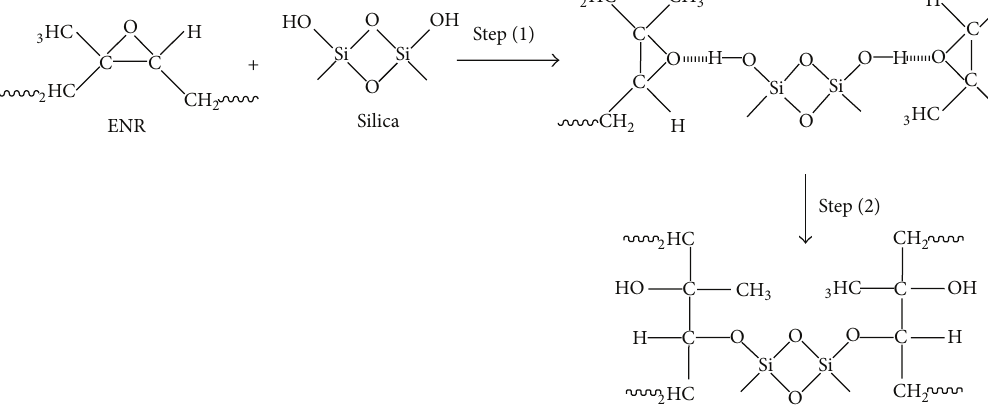
Scheme 1: Possible chemical interaction between ENR and silica.